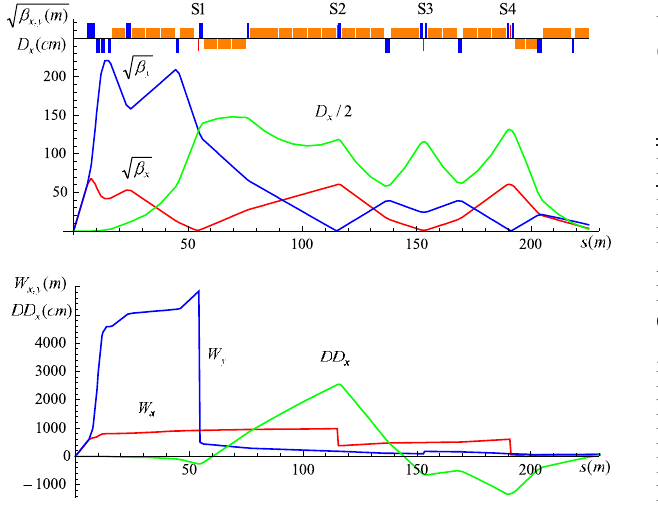
FIG. 1. IR layout and optics functions (top) and chromatic functions (bottom).